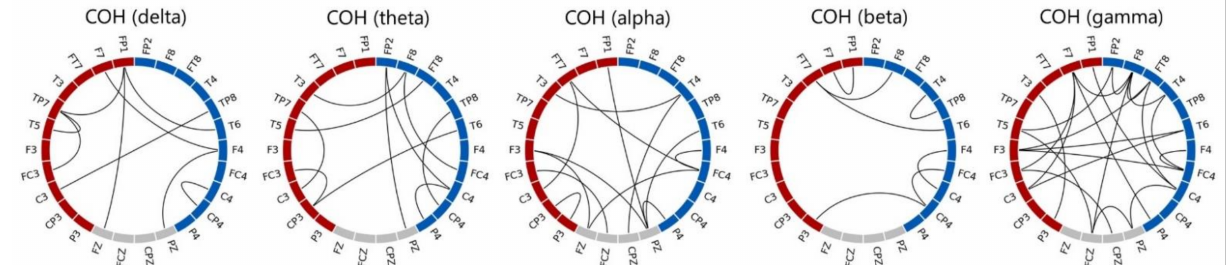
Figure 6. Plots of the 61 optimal coherence features of SVM determined by the SBS-based feature selection procedure. Electrodes at the left and right hemispheres are marked in red and blue, respectively. It is noted that the line connected between an electrode pair does not represent that the coherence between the two electrodes is higher than a threshold, but shows that the coherence feature of the electrode pair is one of the 61 optimal coherence features.